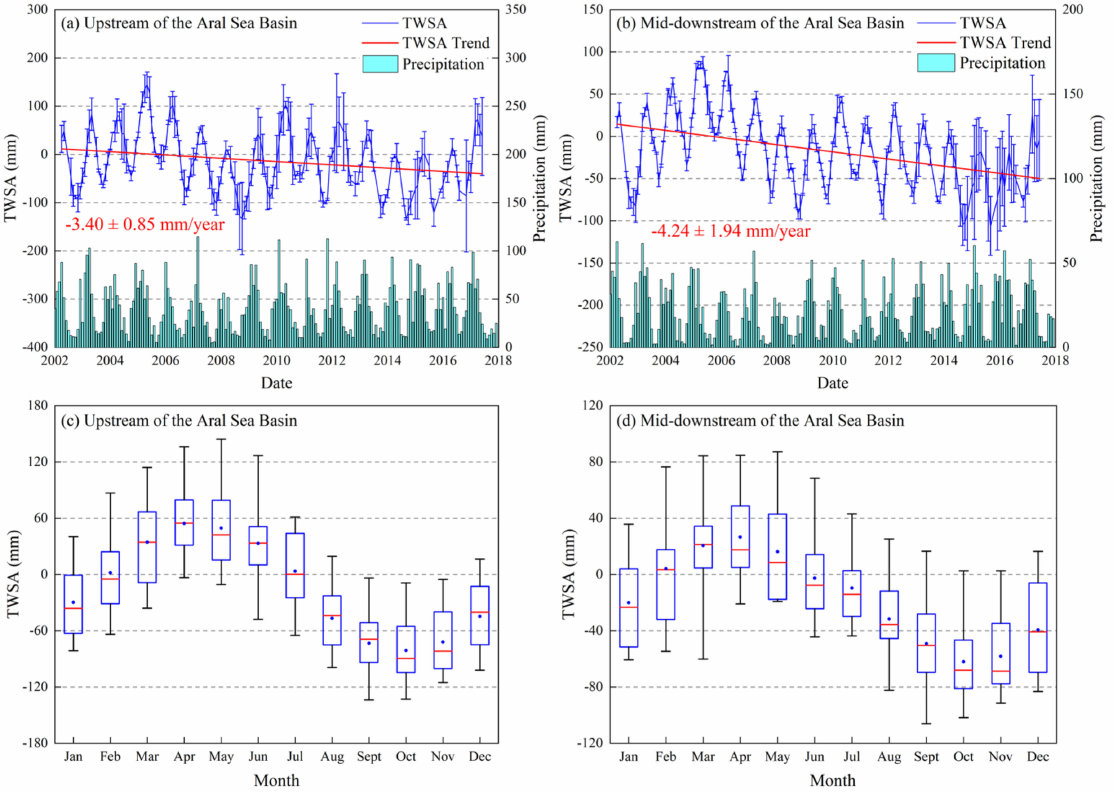
Figure 6. The variations in TWSA and precipitation of the upstream ( a ) and mid-downstream ( b ) of the Aral Sea Basin, and the year-to-year variations in monthly TWSA of the upstream ( c ) and mid-downstream ( d ) of the Aral Sea Basin from April 2002 to June 2017. In ( a , b ), the blue bars represent the data uncertainty. In ( c , d ), the red horizontal lines represent the month’s median TWSA, the blue dots represent the month’s average TWSA, the boxes represent the inner-quartile range, and the whiskers represent the full range of the